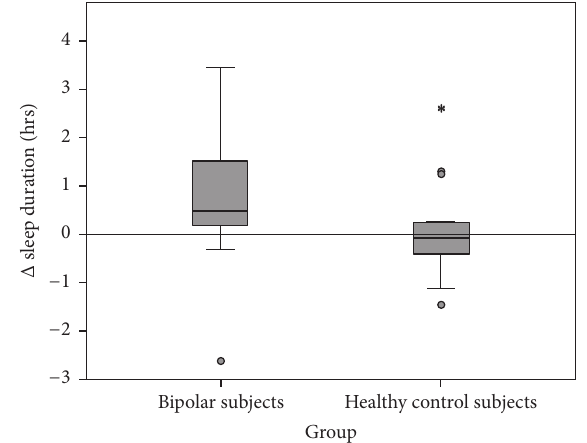
Figure 1: Δ sleep duration. Discrepancy between actimetrically determined values and sleep diary. Positive values indicate subjec- tive underestimation of sleep duration.